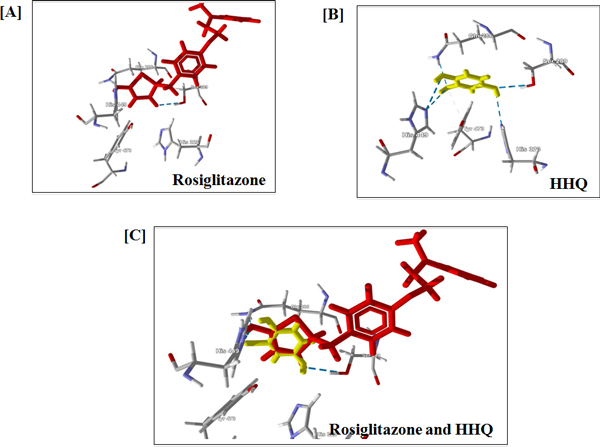
HHQ docked in the ligand binding domain of PPARγ protein crystal structure for PDB solved in conjunction with Rosiglitazone (PDBID: 2PRG). [A] Represents hydrogen bonds (in black dotted line) observed for Rosiglitazone (in red) with the active site residues in the ligand binding domain of PPARγ (2PRG). [B] Represents hydrogen bonds (in black dotted line) observed for HHQ (in yellow) with the active site residues in the ligand binding domain of 2PRG. [C] Represents superposition of the best conformation of Rosiglitazone (in red) and HHQ (in yellow) in the ligand binding domain of 2PRG.